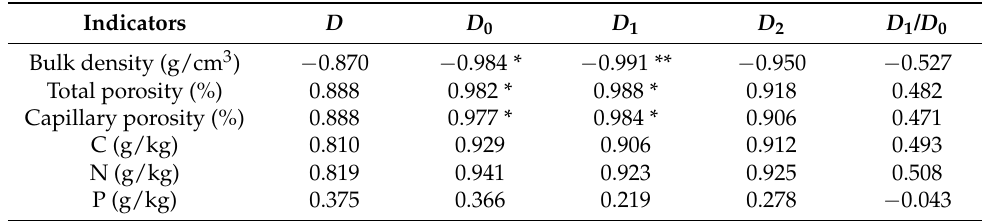
* indicates a significant correlation at the 0.05 level and ** indicates a highly significant correlation at the 0.01 level. There was a positive correlation between soil C, N and P content and fractal